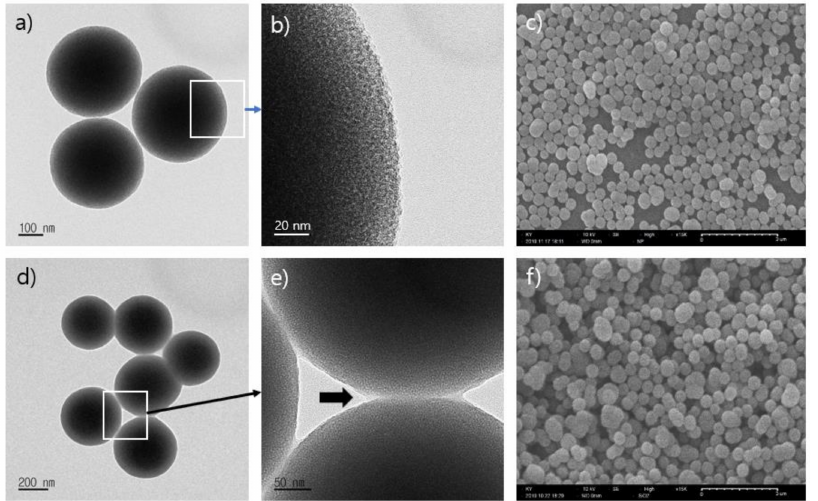
Figure 2. Transmission electron micrograph (TEM) images of ( a ) mesoporous silica particles (mSiO 2 ); ( b ) enlarged image of rectangle region in a); ( c ) scanning electron micrograph (SEM) image of mSiO 2 particles; TEM images of ( d ) europium complexes, Eu(TTA) 3 (P(Oct) 3 ) 3 , decorated mSiO 2 (Eu(TTA) 3 (P(Oct) 3 ) 3 @mSiO 2 ); ( e ) enlarged image of rectangle region in d); ( f ) SEM image of Eu(TTA) 3 (P(Oct) 3 ) 3 @mSiO 2